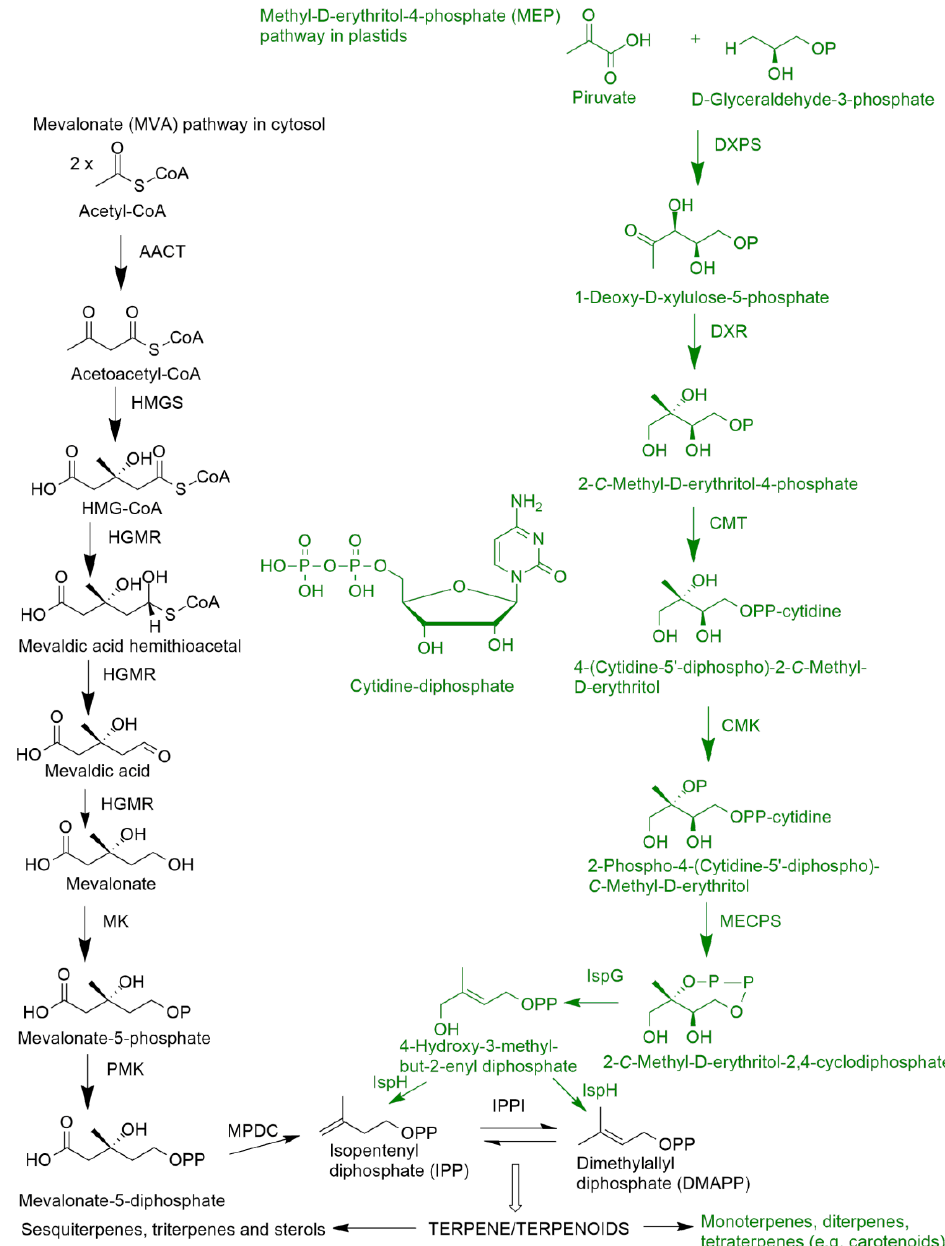
Figure 5. Biosynthesis of isopentenyl diphosphate (IPP) and dimethylallyl diphosphate (DMAPP) by the mevalonate (MVA) and methyl-D-erythritol-4-phosphate (MEP) pathways as well the enzymes involved in such pathways. AACT: Acetoacetyl-CoA-thiolase; CMK: 4-diphosphocytidyl-2-C-methyl- D-erythritol kinase; DXR: 1-deoxy-D-xylulose-5-phosphate reductase; DXPS: 1-deoxy-D-xylulose5- phosphate synthase; HDR: (E)-4-hydroxy-3-methyl-but-2-enyl diphosphate reductase; HMGR: 3- hydroxy-3-methylglutaryl-CoA reductase; HMGS: 3-hydroxy-3-methylglutaryl-CoA synthase; IPPI: isopentenyl diphosphate isomerase; IspG: 4-hydroxy-3-methylbut-2-enyl diphosphate synthase; IspH: 4-hydroxy-3-methylbut-2-enyl diphosphate reductase; MDPC: mevalonate-5-diphosphate decarboxylase; MECPS: MEP cytidyltransferase; MK: mevalonate kinase; PMK: phosphomevalonate kinase (adapted from